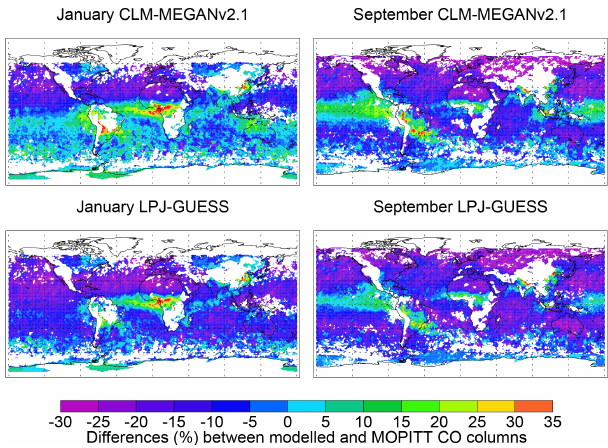
Figure 6. Percentage differences between ensemble model mean and MOPITT CO columns for January and September 2005, from two simulations with CLM-MEGANv2.1 (top) and LPJ-GUESS (bottom) biogenic emissions,